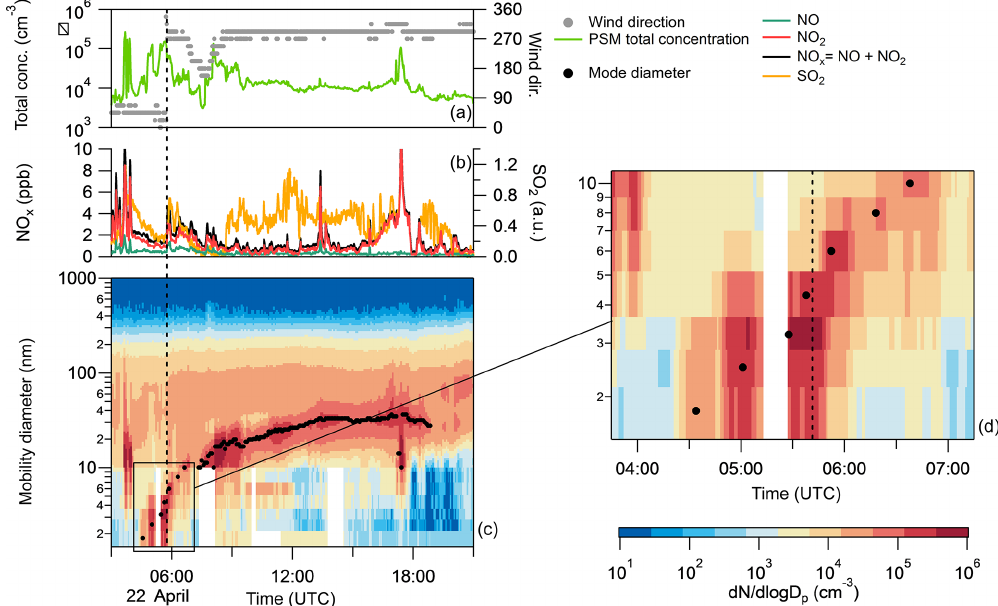
Figure 5. NPF event on 22 April 2017. Panel (a) shows the 1min averaged time series of the total particle concentration measured by the PSM on a logarithmic scale and the wind direction (grey markers). Trace gases (NO, NO 2 , NO x = NO + NO 2 ) are shown in panel (b) . in blue, red and black. The qualitative SO 2 data were added in orange. In panel (c) , the size distribution from DMA-train and MPSS data during the complete NPF event is shown. Panel (d) depicts a close-up of the start of the NPF event that exhibits bursts of particles in two stages before continuous particle growth takes off. The mode diameter is shown as black markers, and the black dashed line indicates the change in wind direction (grey markers in upper